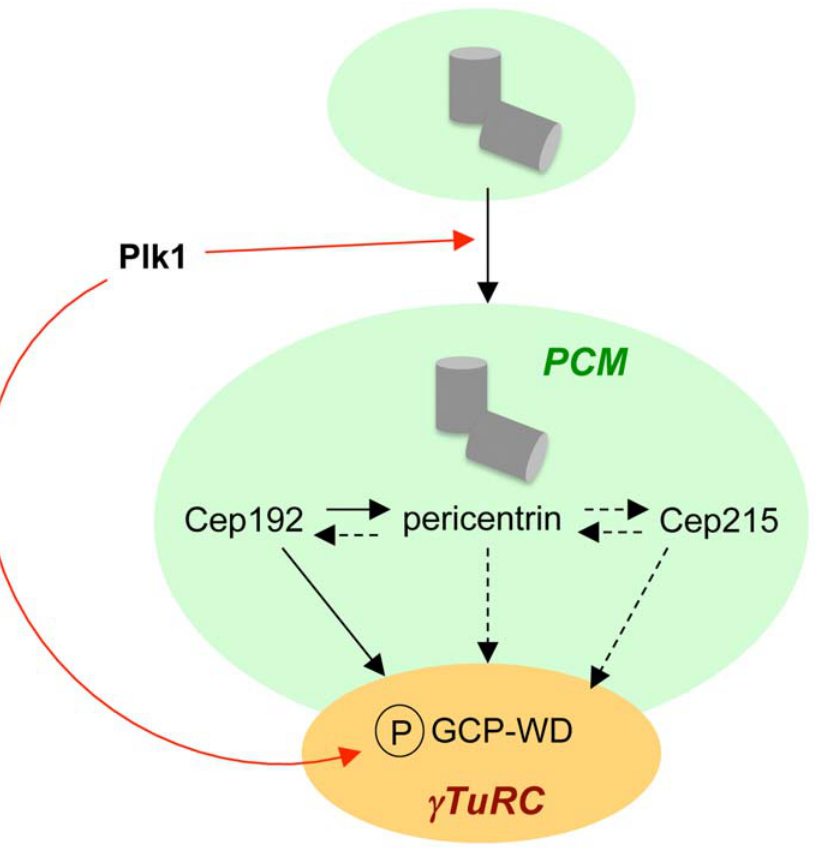
Figure 7. Interdependencies of components involved in the recruitment of c -tubulin complexes to mitotic centrosomes. During centrosome maturation Plk1 phosphorylates PCM components, which results in the accumulation of PCM including c TuRC recruitment factors at mitotic centrosomes. Plk1-dependent phosphorylation of GCP-WD does not affect centrosome recruitment of c TuRCs, which is regulated upstream of GCP-WD. Upstream regulators and potential Plk1 substrates include Cep192, pericentrin, and Cep215. Pericentrin and Cep215 contribute to each other’s centrosome localization and to c TuRC binding. Pericentrin is also important for centrosome localization of Cep192, which has the strongest impact on centrosome recruitment of GCP-WD/ c TuRC [24,25]. Solid black arrows indicate an essential role in the recruitment of the component they are pointing at, dashed black arrows indicate a partial role. Red arrows indicate Plk1-dependent regulation.